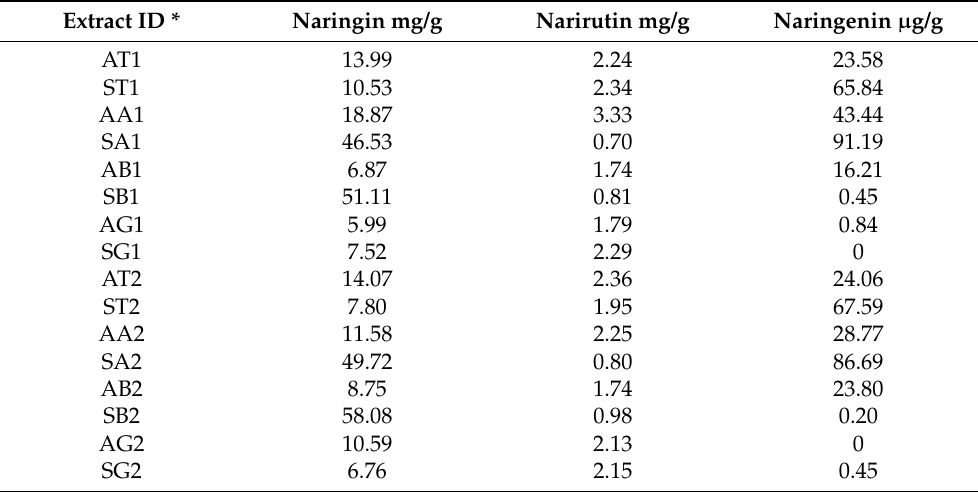
Table 4. Flavanone concentrations retrieved from samples using CDs.